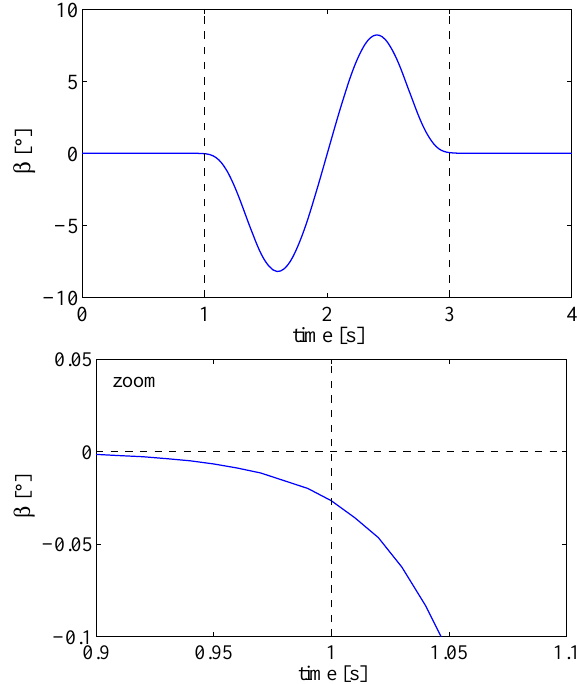
Figure 16. Rotational manipulator arm: computed trajectory of un- actuated coordinate β